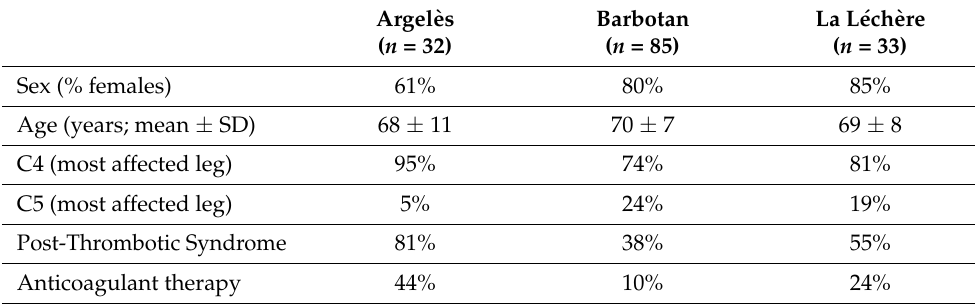
Table 1. Main characteristics of the patients enrolled in the three study sites.